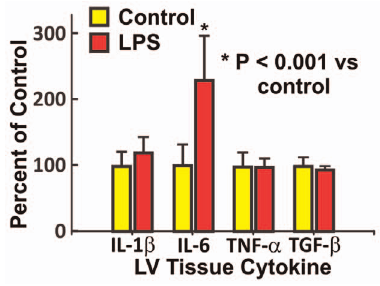
Figure 9. LPS increased IL-6 expression in the left ventricle. Expression of the cytokines IL-1 b , IL-6, TNF- a and TGF- b (mean + SEM percent of control) were measured in the left ventricle after 3 months of LPS (20 mg/kg/week i.p, n=5) or saline (n=6). There was a significant increase in IL-6 (P , 0.001), but no significant change in IL-1 b , TNF- a , or TGF- b .